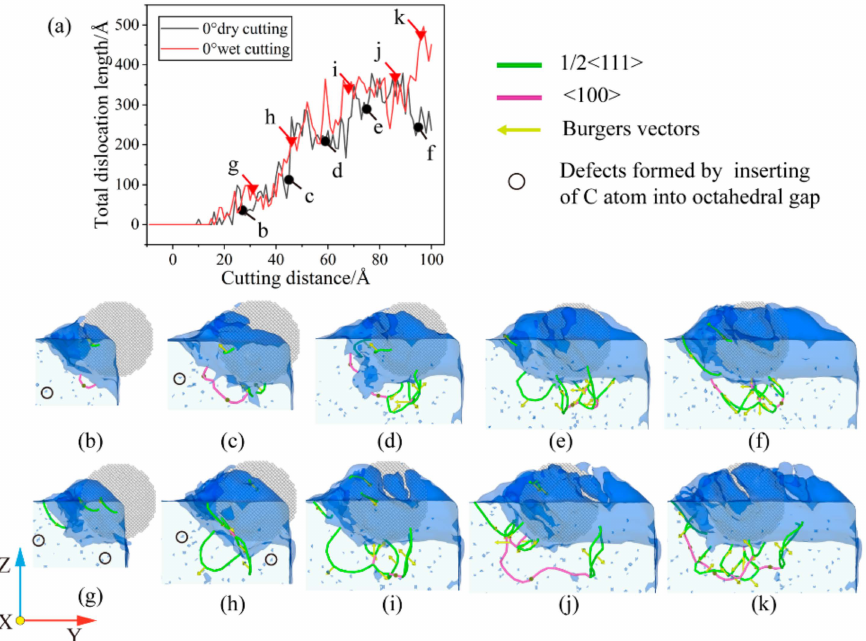
Figure 12. Dislocation evolution under θ = 0 ◦ . ( a ) Variation of total length of dislocation with cutting distance; ( b ) cutting distance of 26 Å under dry cutting; ( c ) cutting distance of 45 Å under dry cutting; ( d ) cutting distance of 59 Å under dry cutting; ( e ) cutting distance of 75 Å under dry cutting; ( f ) cutting distance of 95 Å under dry cutting; ( g ) cutting distance of 30 Å under wet cutting; ( h ) cutting distance of 46 Å under wet cutting; ( i ) cutting distance of 69 Å under wet cutting; ( j ) cutting distance of 85 Å under wet cutting; and ( k ) cutting distance of 96 Å under wet cutting.